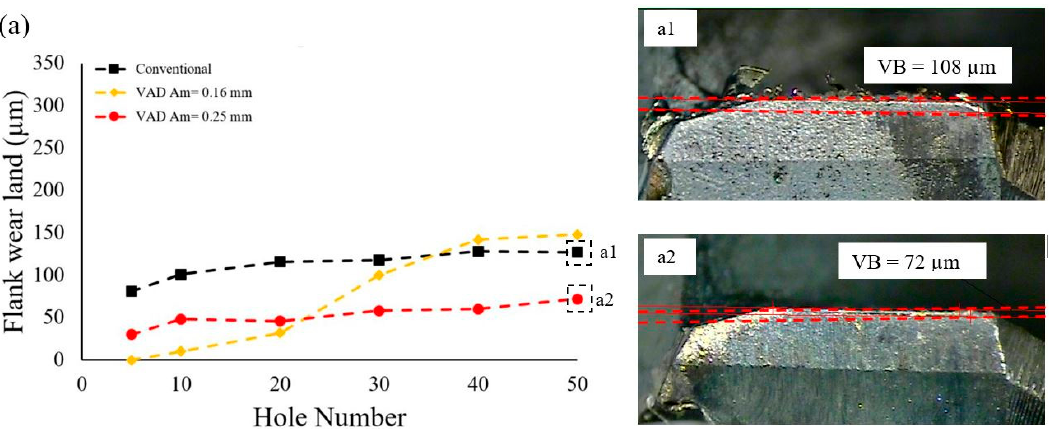
Figure 9. The effect of vibration amplitude on the tool flank land wear for N = 37.68 m/min and f = 0.075 mm/rev.